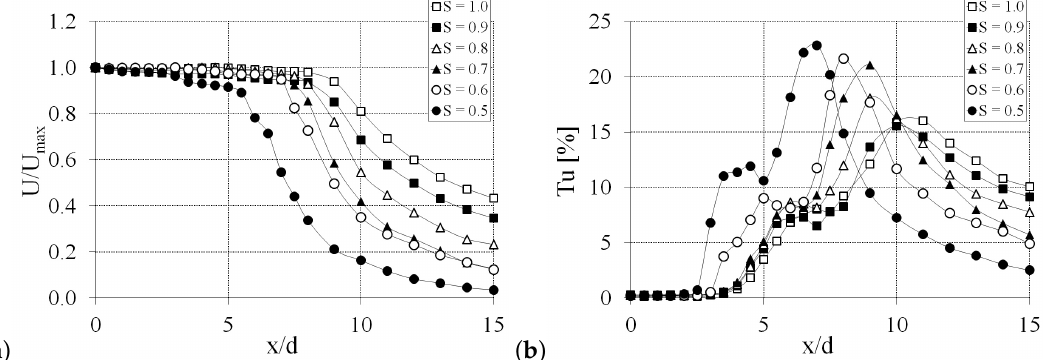
Figure 2. ( a ) Mean and ( b ) fluctuating velocity profiles along the jet axis, L / D = 7, Re = 5000.